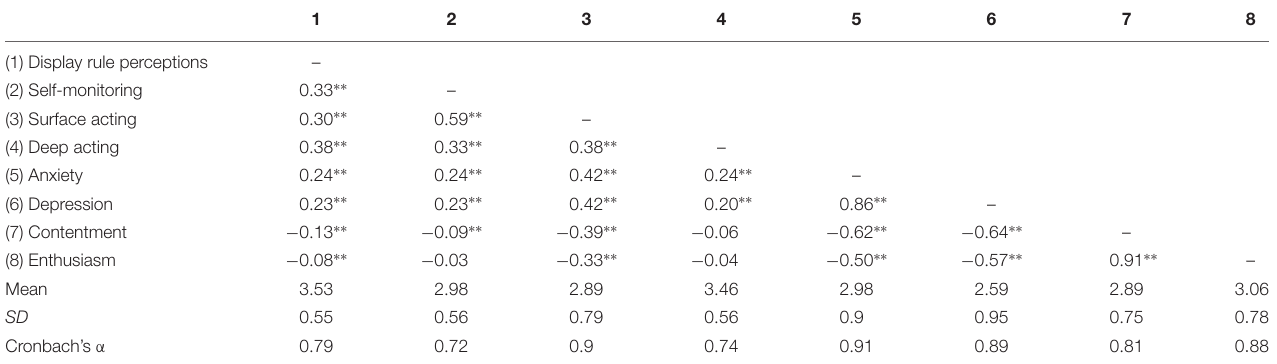
TABLE 2 | Descriptive statistics and latent factor correlations based on CFA.